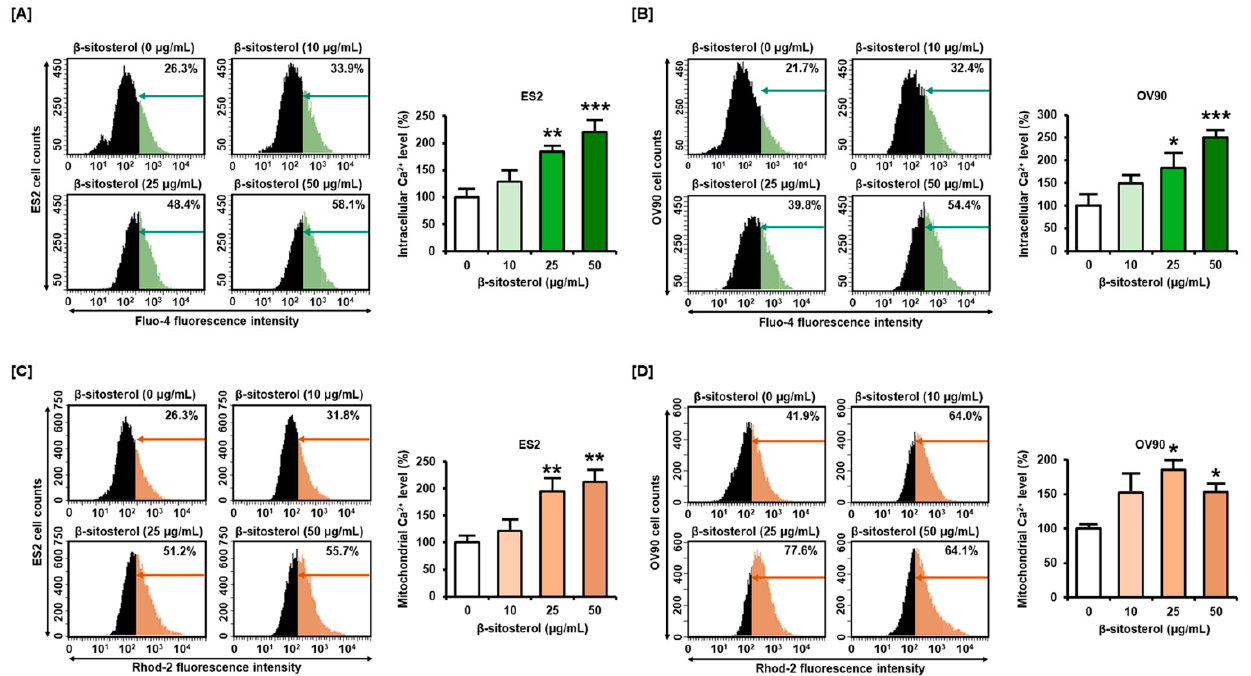
Figure 3. Calcium concentration in cytosol and mitochondria of β -sitosterol-treated ovarian cancer cells. ( A , B ) Fluo-4 dye was used to investigate the intracellular calcium levels. The histograms represent the change of cytosolic calcium by β - sitosterol (0, 10, 25, and 50 µ g/mL) in ES2 and OV90. ( C , D ) Rhod-2 fluorescence was analyzed to investigate mitochondrial calcium levels in β -sitosterol-treated ovarian cancer cells. The histograms represent changes in mitochondrial calcium caused by β -sitosterol (0, 10, 25, and 50 µ g/mL) in ES2 and OV90 cells. Comparative bar graphs represent the change of cytosolic and mitochondrial calcium levels by β -sitosterol compared to the vehicle-treated control (100%) in ES2 and OV90. The asterisks indicate significant differences between treated and control cells (*** p < 0.001, ** p < 0.01, and * p < 0.05).